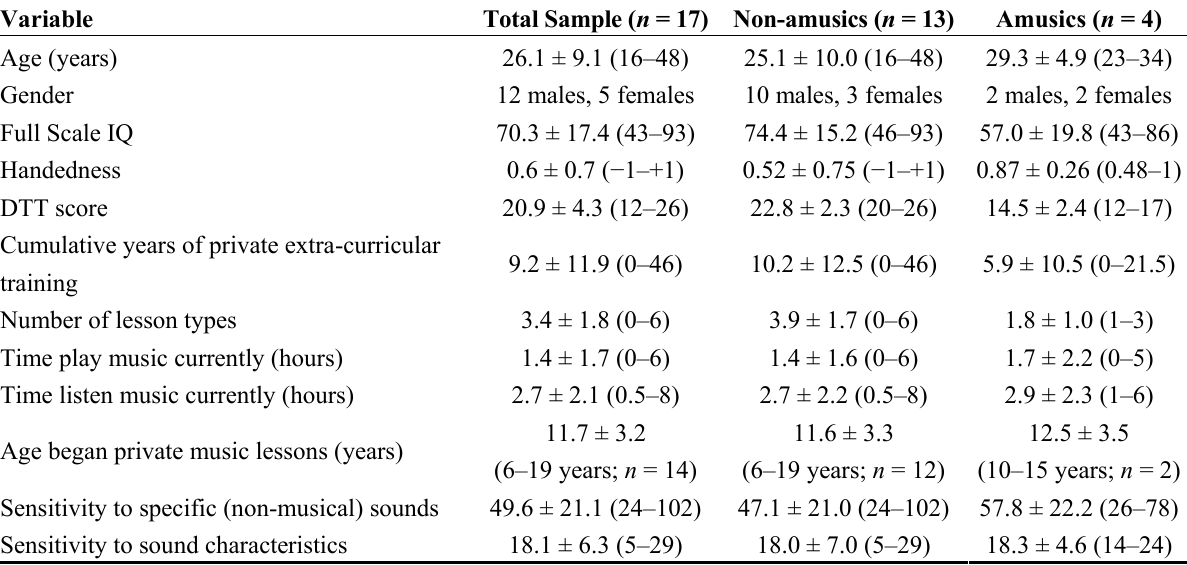
Table 1. Demographic and musical background information (Mean ± SD